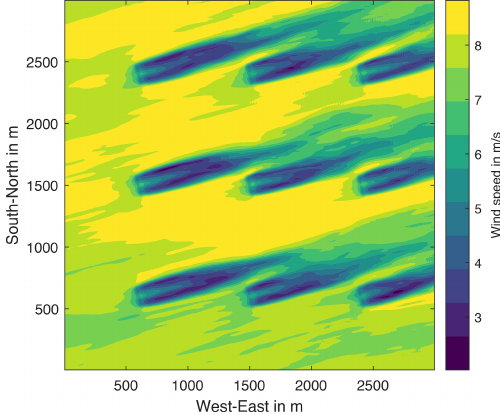
Figure A2. Averaged wind speed from t = 500 to 600s, divided into 11 speed